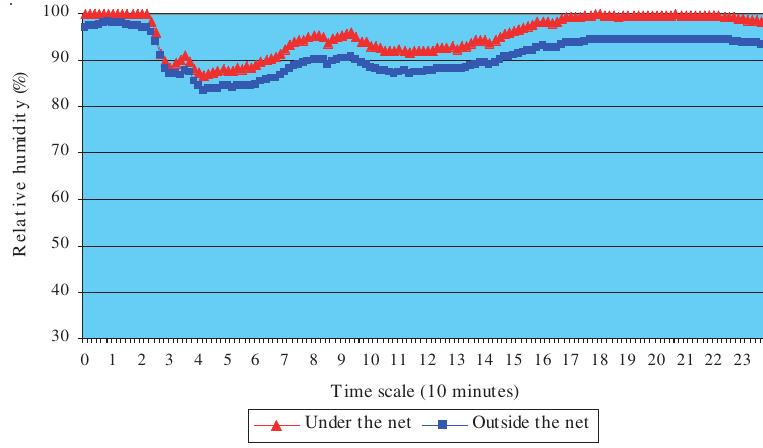
>60%) /Pallag 2011 dif